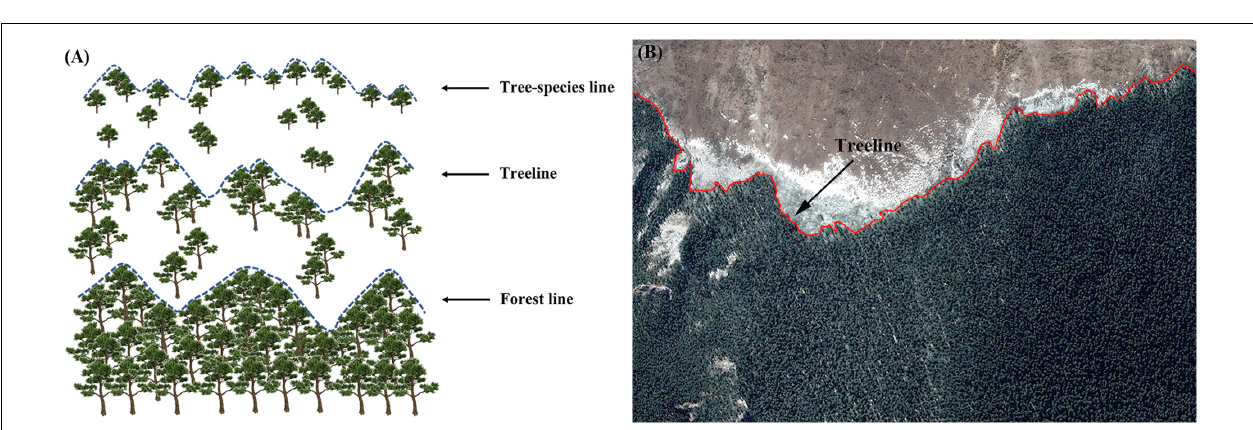
FIGURE 2 | (A) The position of treeline. (B) Extraction of treeline from Google Earth